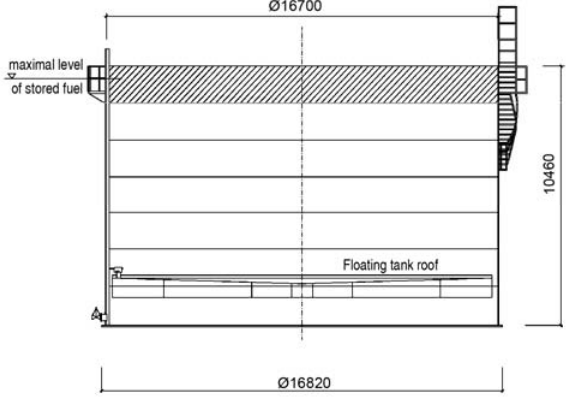
Fig. 1. Outline of tanks No. 3 and No. 4 with marked belt of side surface, from where corroded material was sam- pled